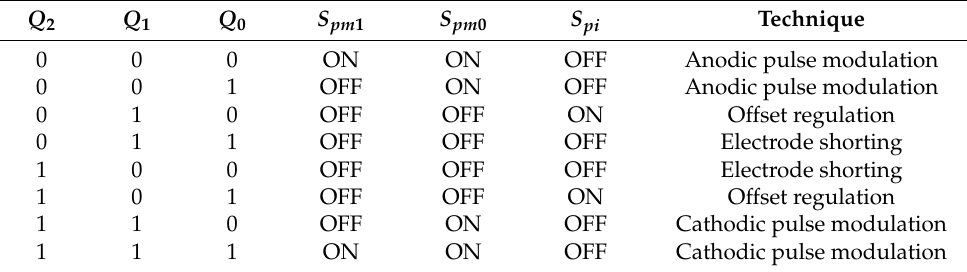
Figure 5. Circuit configuration of hybrid charge balancing mode (HCBM). Table 1. Adjustment control unit